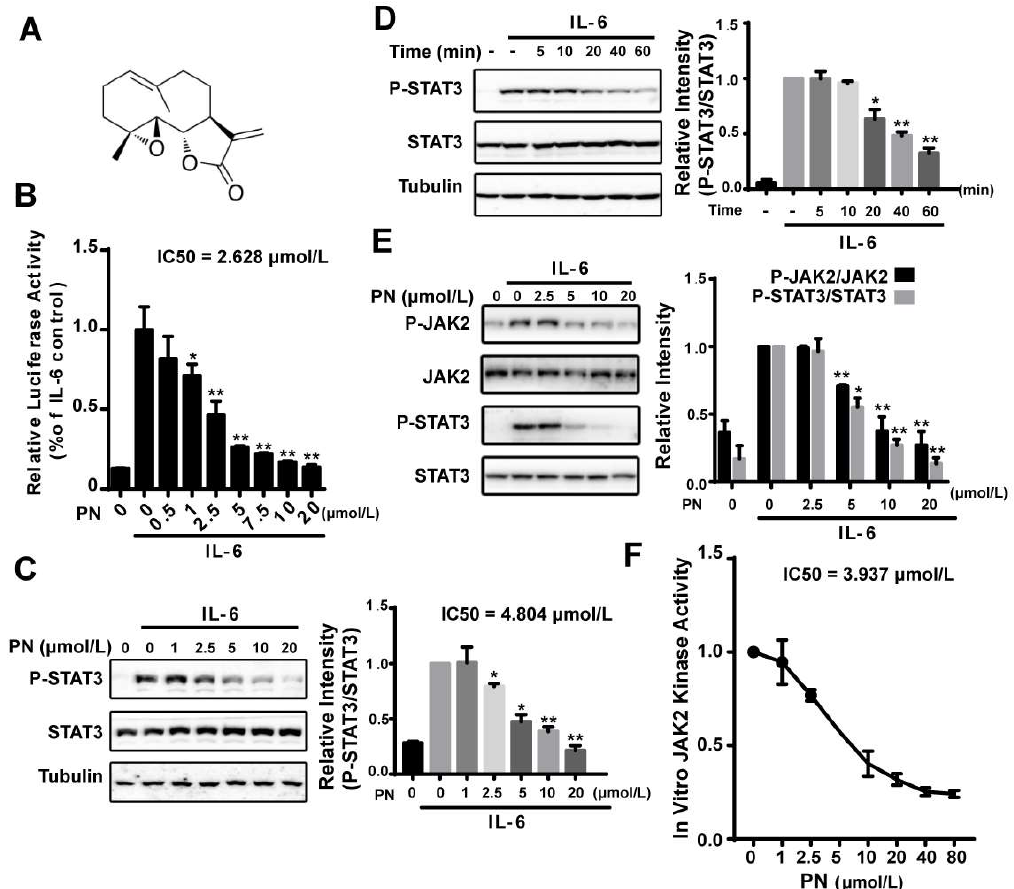
Figure 1. Parthenolide inhibited the IL-6-induced STAT3 phosphorylation by inhibiting JAK2 kinase activity. ( A ) Structure of parthenolide. ( B ) Effects of PN on the IL-6-induced luciferase activity. HepG2/STAT3 cells were treated with PN for 1 h before stimulation by 10 ng/mL IL-6 for 4 h. Cells were harvested to determine the luciferase activity. ( C , D ) PN inhibited IL-6-induced STAT3 phosphorylation. MDA-MB-231 cells were treated with PN at various concentrations for 1 h or with 5 μmol/L PN for various durations before stimulation by IL-6 (10 ng/mL) for 10 min. Cell lysates were processed for Western blot analysis. ( E ) Effects of PN on IL-6-induced JAK2 phosphorylation. MEF cells were treated with PN for 1 h before stimulation by IL-6 (10 ng/mL) for 10 min. Cell lysates were processed for Western blot analysis. ( F ) JAK2 in vitro kinase assay. The experiment was conducted as described in the Materials and Methods. ( n = 3, * p < 0.05, ** p < 0.01 compared with IL-6-induced cells, one-way ANOVA).